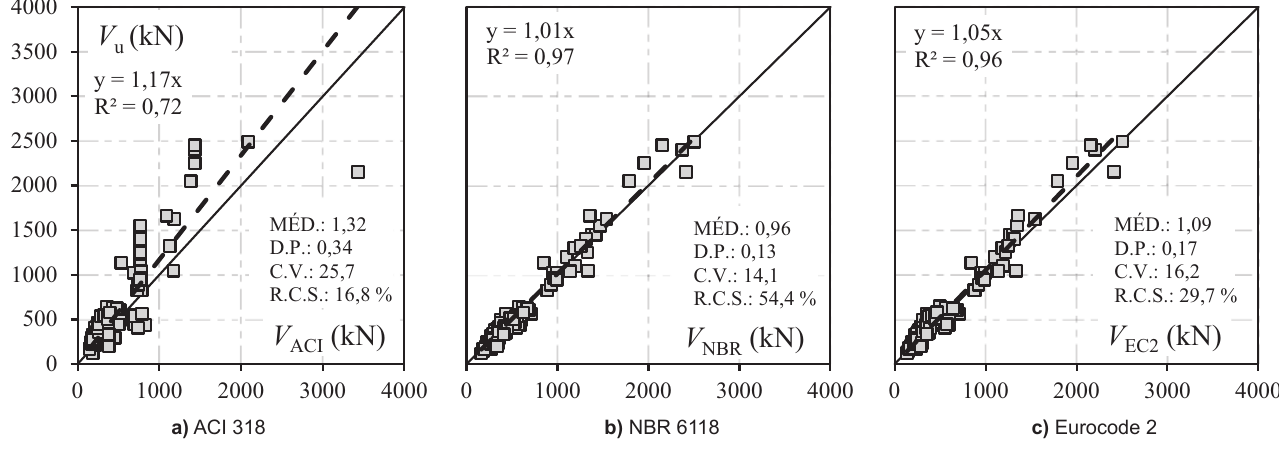
Precisão das normas na estimativa da resistência à punção de lajes sem armadura de